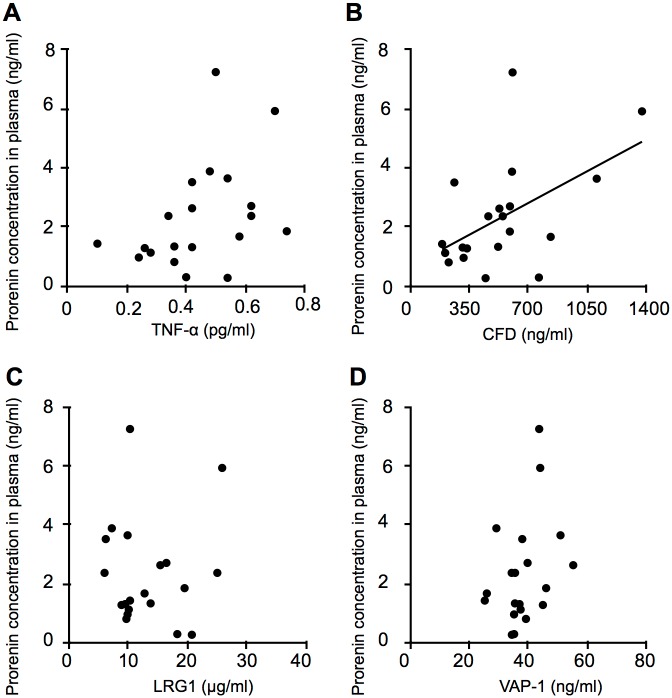
Correlations between prorenin and inflammatory mediators elevated in the plasma of PDR patients.Correlations between prorenin and inflammatory mediators TNF-α (A), CFD (B), LRG1 (C) and VAP-1 (D) in the plasma of patients with PDR (n = 20, Spearman rank correlation).